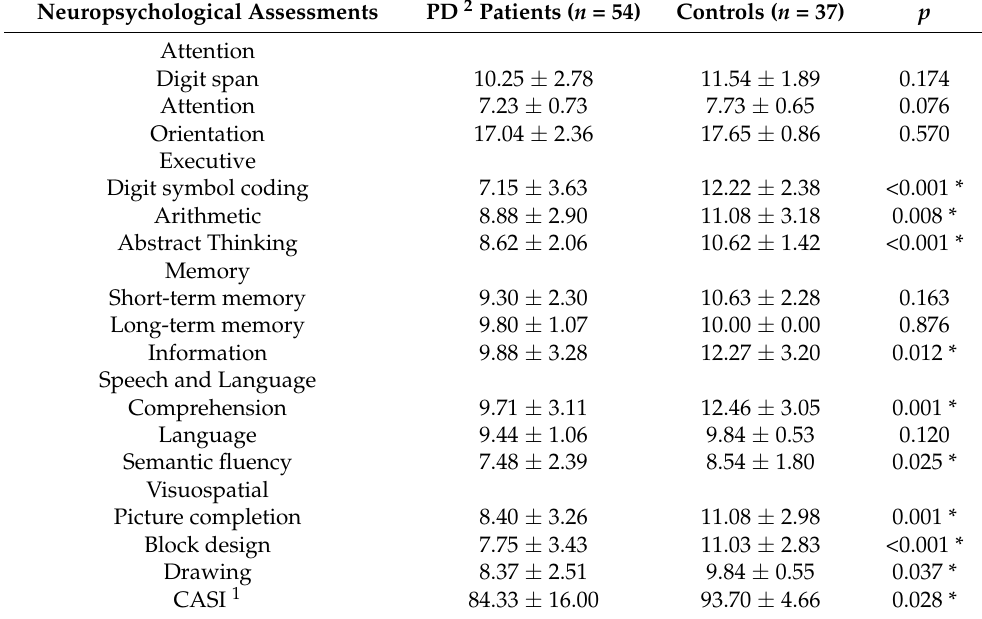
Table 2. Analysis of neuropsychological assessments between Parkinson’s patients and normal controls. All the neuropsychological assessments were compared with ANCOVA after controlling age, sex, and education levels. Data are presented as mean ± standard